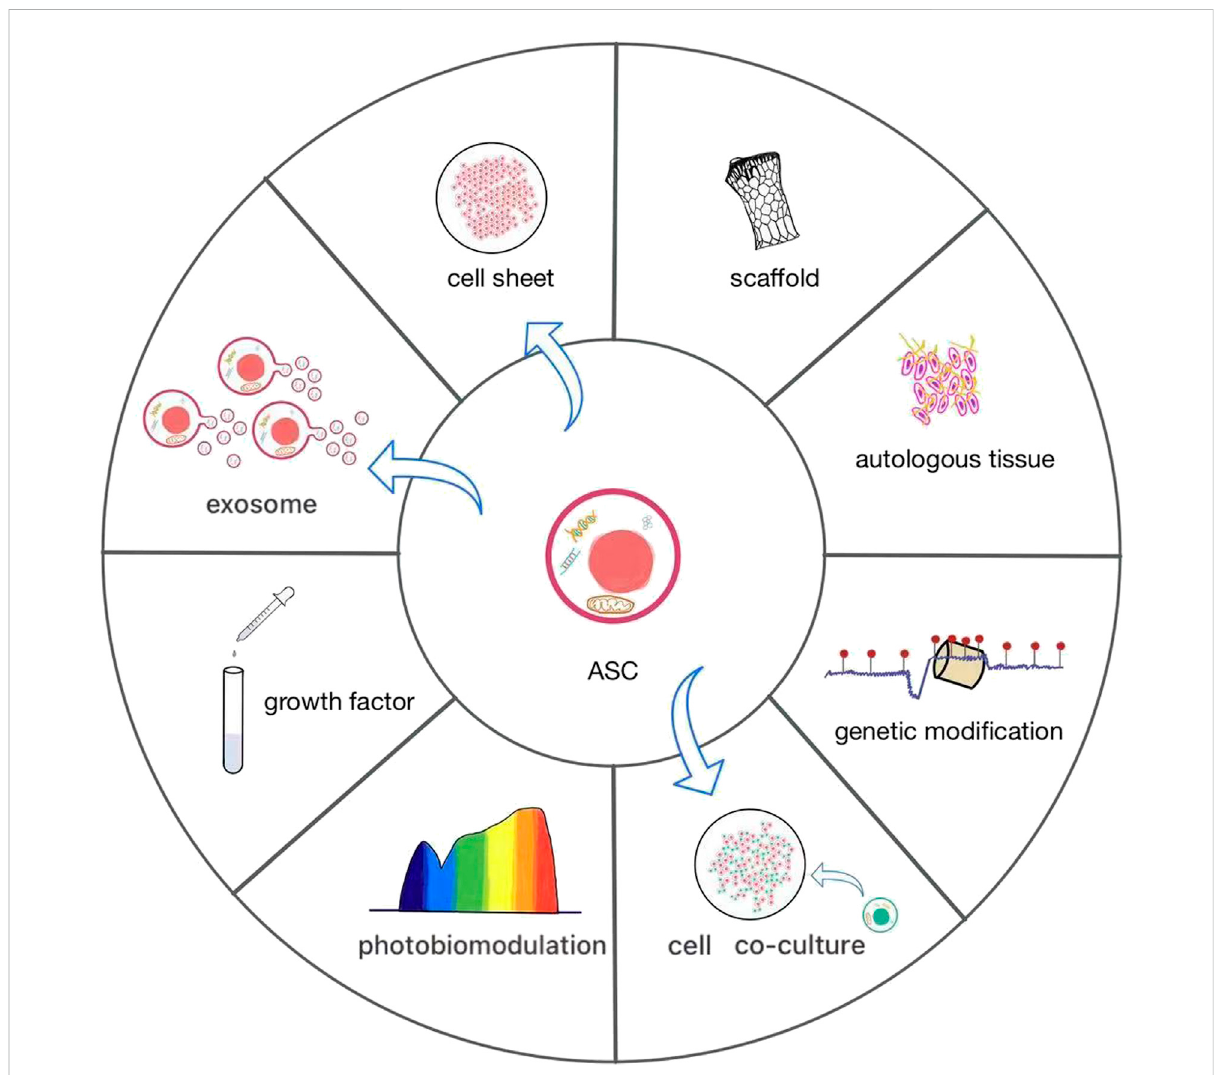
FIGURE 3 The current various applications of ASCs. ASCs have rarely been used alone, often as cell sheets or combined with scaffolds to promote osteogenesis. It is effective to add autologous tissue and growth factors or construct co-culture systems in ASCs. They are increasingly widely used biological methods, which contribute to the growth and differentiation of ASCs. Photobiomodulation and genetic modi fi cation are novel and worthwhile effortsto givean impetusto theosteogenicdifferentiationofASCs. Directapplication ofexosomesofASCs canalsopromotebone